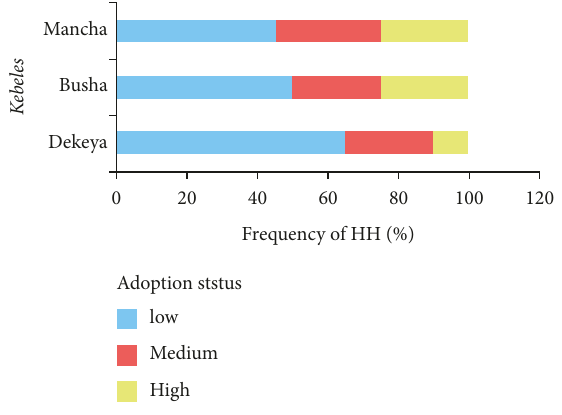
Figure 2: Adoption status of SSI in the study area. Table 3: Statistical summary of users and nonusers sampled on continuous